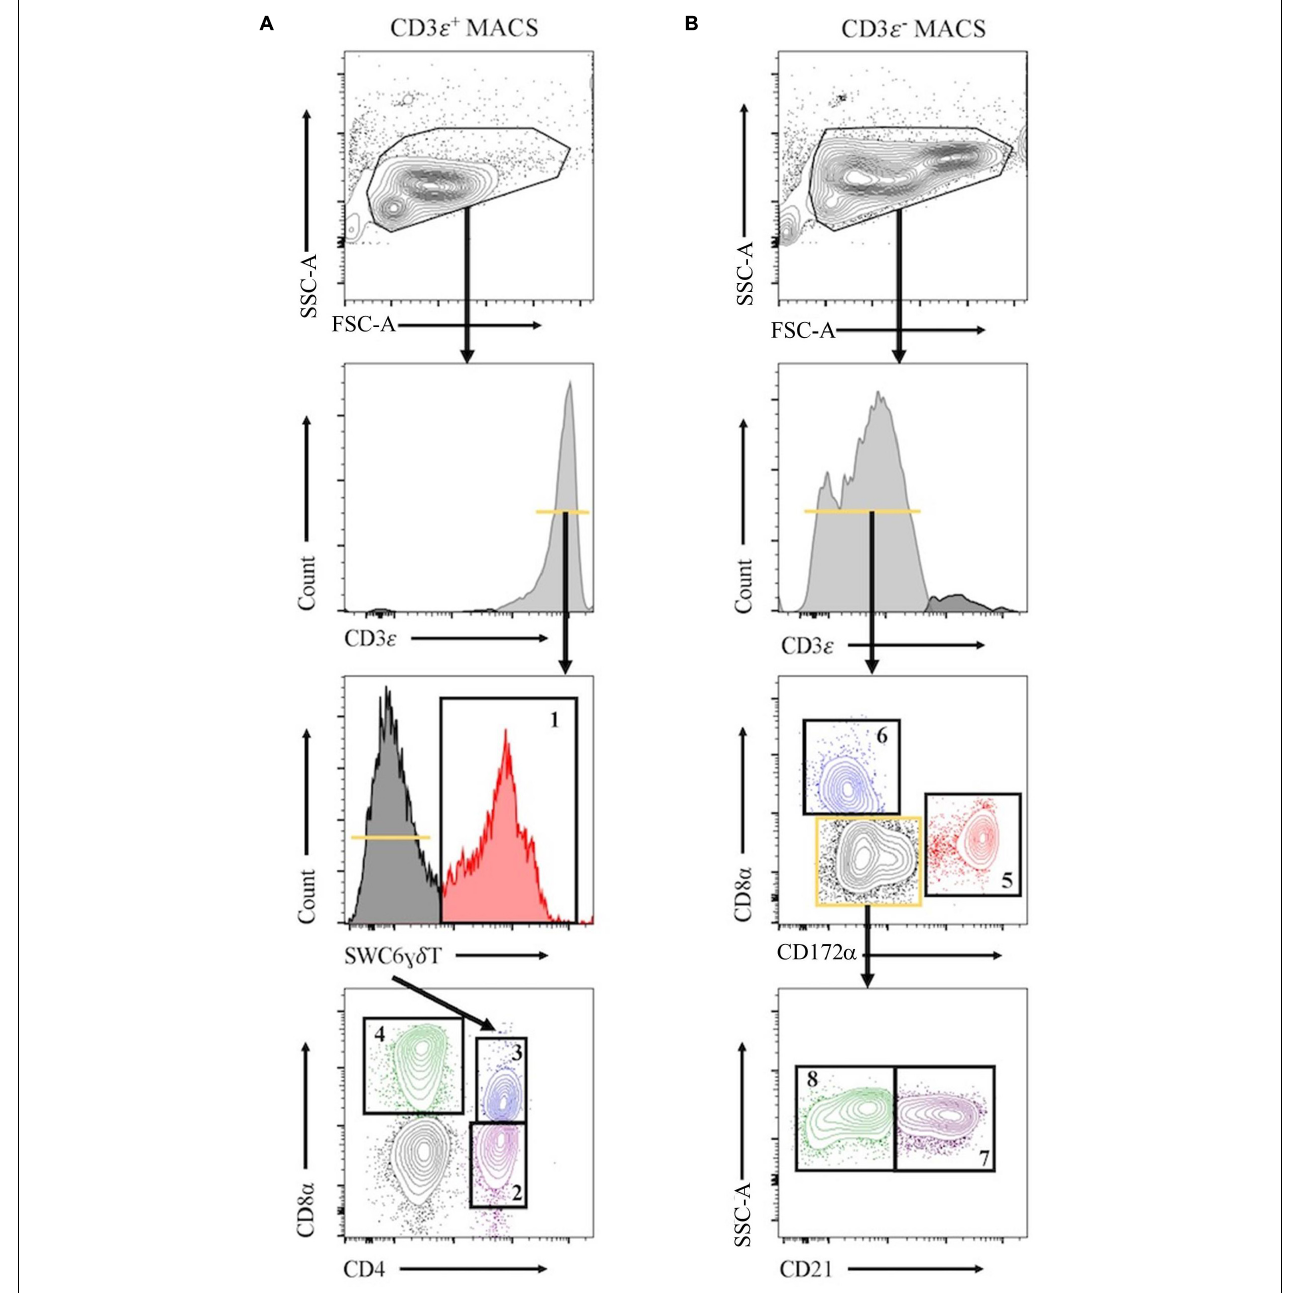
FIGURE 1 | Representative plots for fluorescence-activated cell sorting (FACS) isolation of 8 leukocyte populations from pig peripheral blood mononuclear cells (PBMCs). Porcine PBMCs were first subjected to magnetic-activated cell sorting (MACS) to enrich for CD3 ε + and CD3 ε – fractions. (A) Cells in CD3 ε + MACS fraction were FACS gated on FSC vs. SSC, doublets removed (not shown), and CD3 ε + cells were isolated into 4 population: SWC6 + γδ T-cells (gate 1), and the SWC6 − cells sorted as CD4 + CD8 α − (gate 2), CD4 + CD8 α + (gate 3), CD4 − CD8 α + (gate 4) T-cells. (B) Cells in CD3 ε − MACS fraction were FACS gated on FSC vs. SSC, doublets removed (not shown), and CD3 ε − cells were isolated into 4 populations: CD172 α + myeloid lineage leukocytes (gate 5), CD8 α + CD172 − NK cells (gate 6), and the remaining CD8 α − CD172 α − , cells were isolated as CD21 + (gate 7) and CD21 − (gate 8) B-cells. Table 1 outlines abbreviations and sort criteria for each population.